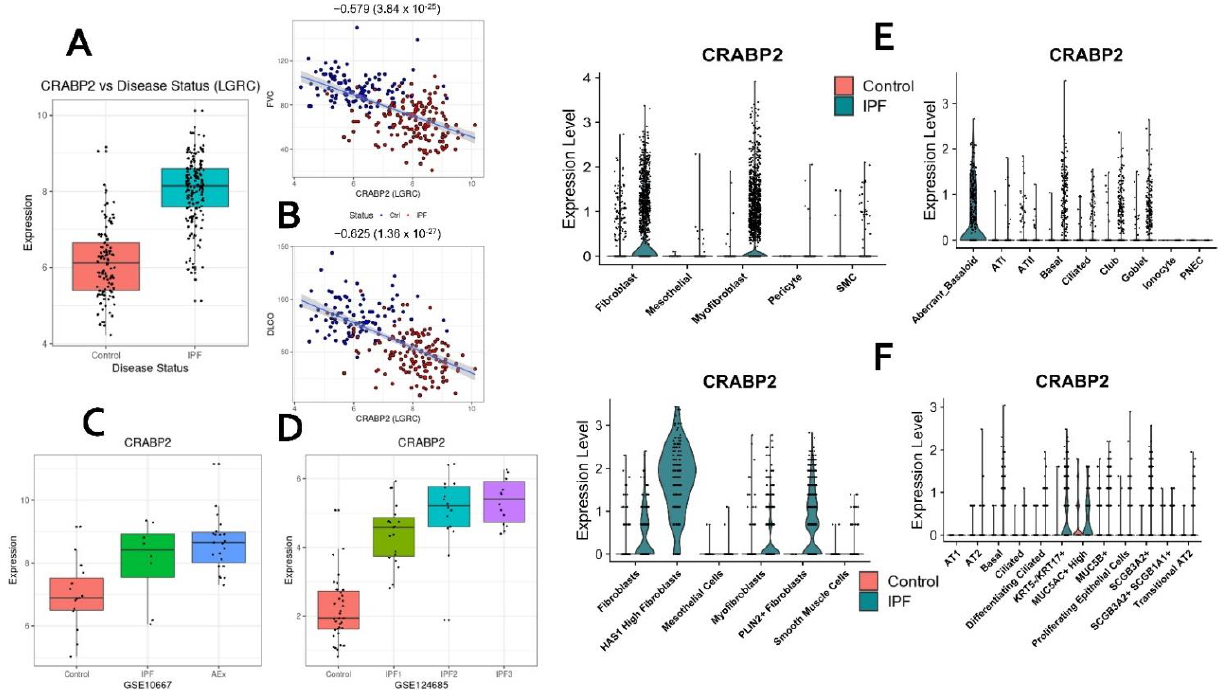
Figure 5. CRABP2 as a novel candidate for IPF. CRABP2 is significantly upregulated in IPF ( A ) and is negatively correlated with lung function (FVC and DL CO ; B ). Additionally, CRABP2 is differentially expressed in acute exacerbation ( C ) and shows a gradient level upregulation in three stages of IPF, namely, early (IPF1), progressive (IPF2), and advanced (IPF3) stages ( D ). CRABP2 is enriched in both epithelial (aberrant basaloid or KRT5-/KRT17+ and goblet cells) and mesenchymal (fibroblast, myofibroblast, HAS1-high fibroblasts, and PLIN2+ fibroblasts) cells ( E,F ). Table 3. List of novel candidate genes capable of distinguishing fibrotic samples from healthy controls in the two training cohorts and two independent validation cohorts (GSE150910 and GSE134692).